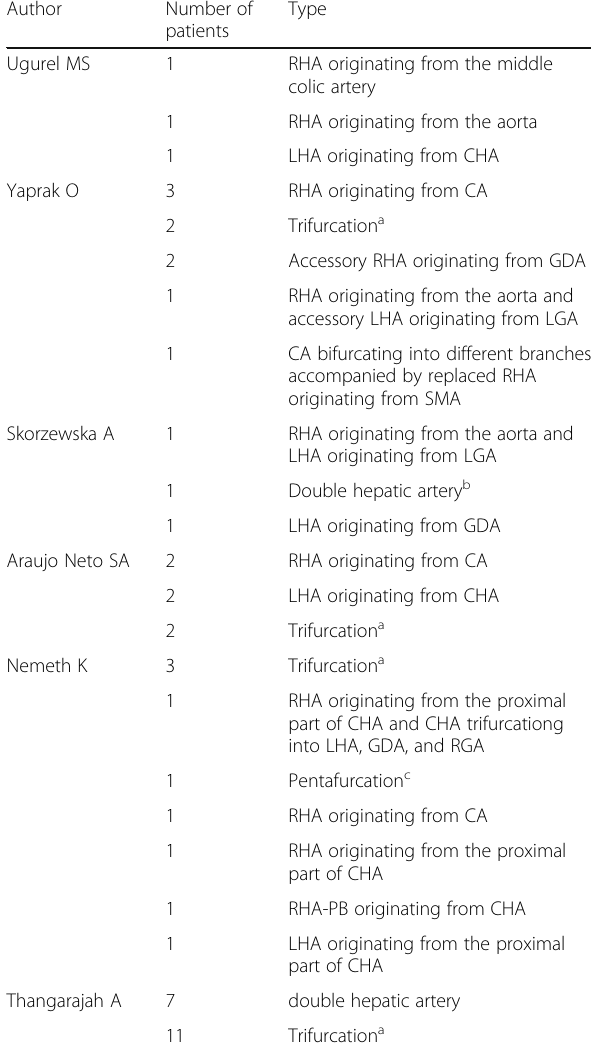
Table 1 Hepatic arterial variations incompatible with the descriptions in the Michels ’